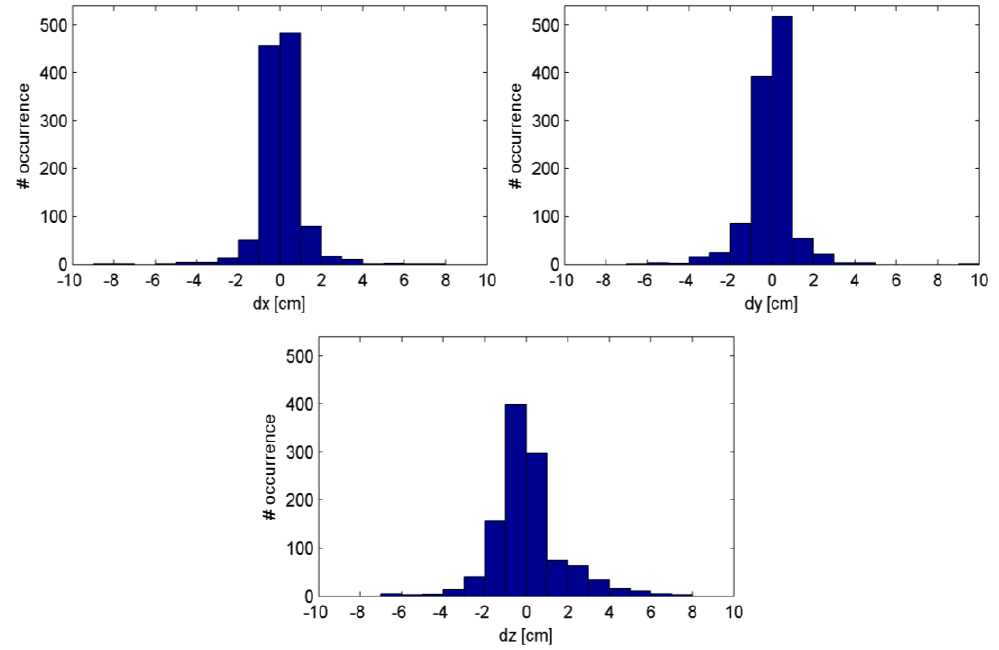
Figure 7. Histograms of discrepancies between the closest point pairs in X, Y and Z